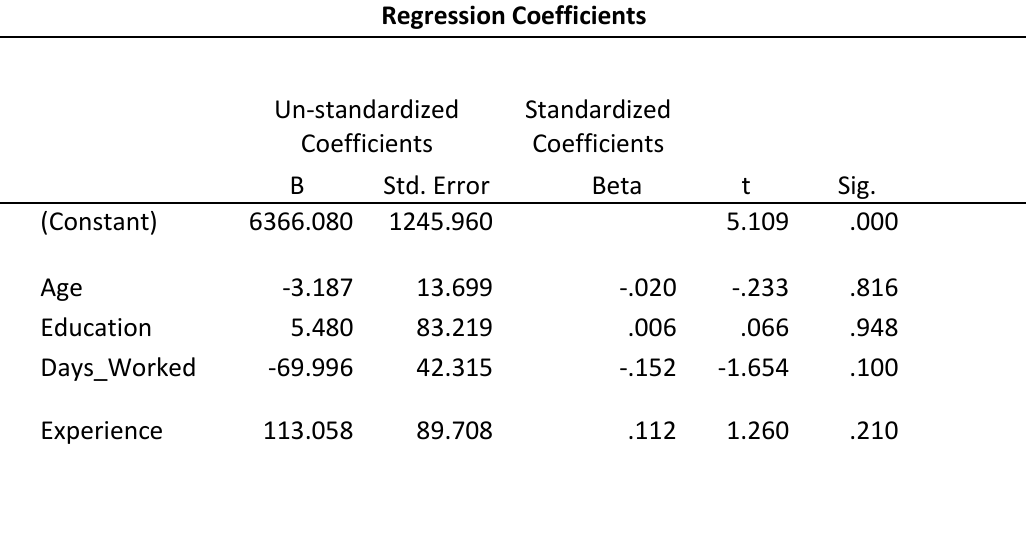
Table 4: Estimates on Dependent Variable: Wages Regression